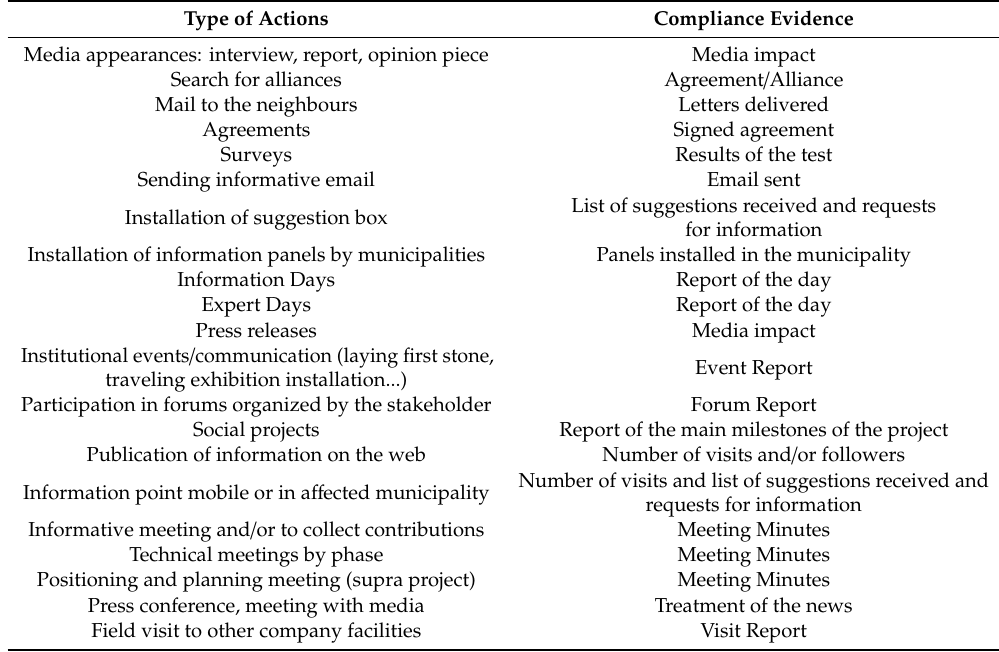
Table A2. Type of actions to apply in stakeholder management with its Compliance evidence.